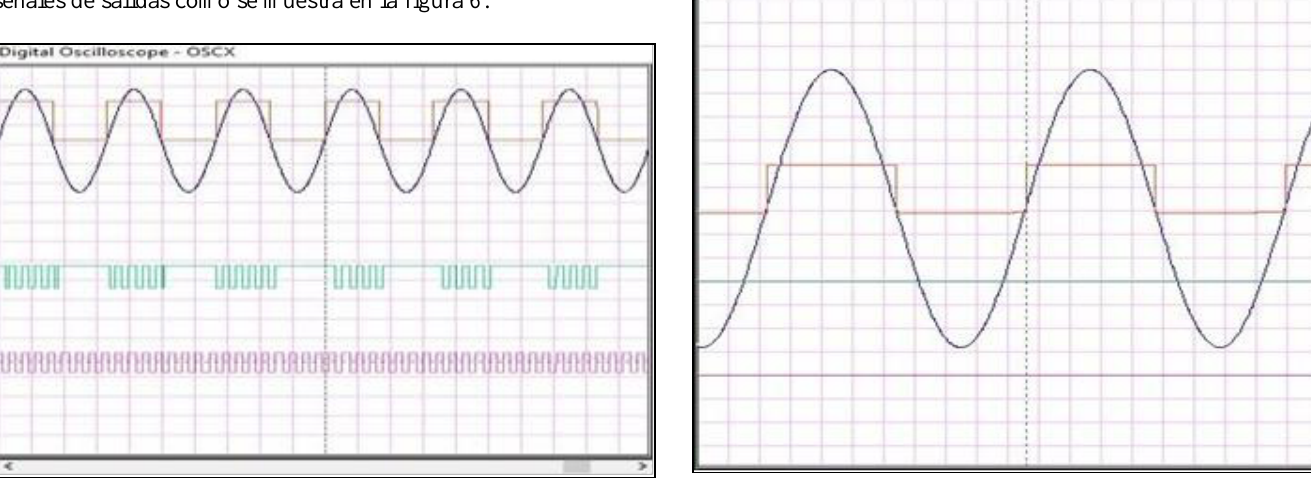
Figura 6: Señales de entrada y salida del micro controlador PIC 18f4550.